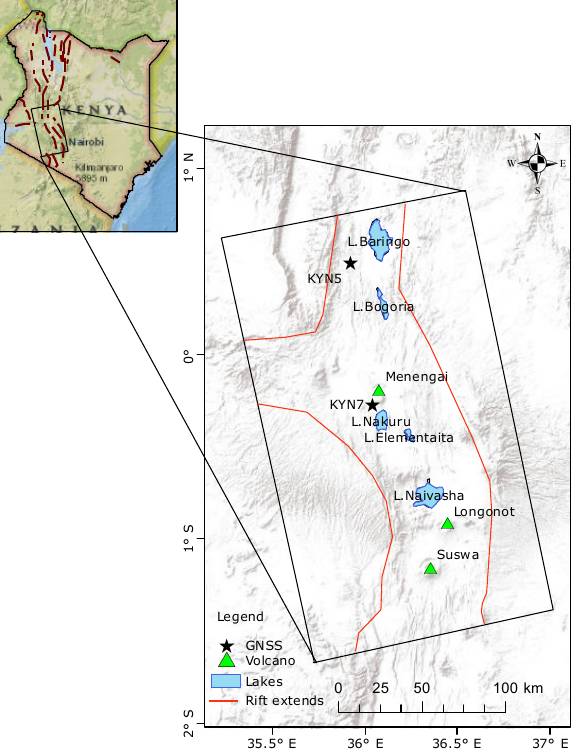
Figure 1. Map showing the study area, location of volcanoes, lakes, and the two GNSS stations KYN5 and KYN7 from the Uganda-Kenya Eastern Branch GNSS